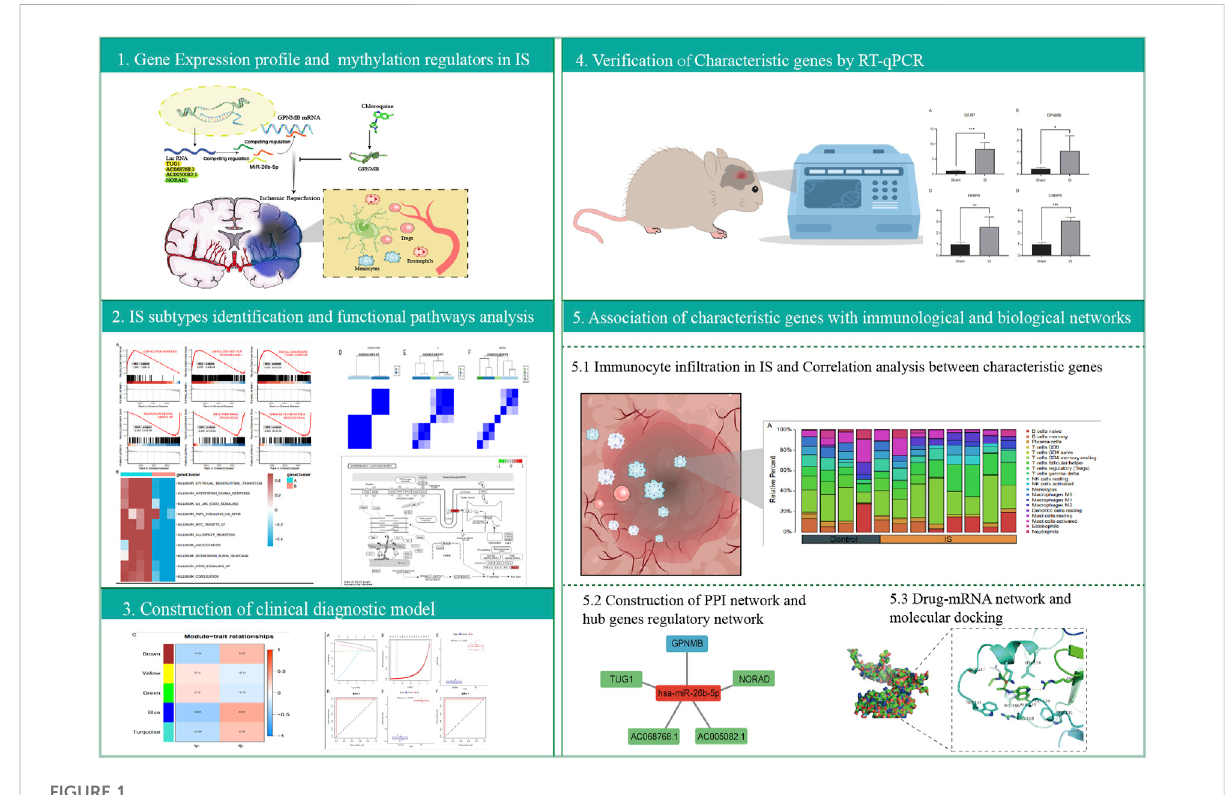
FIGURE 1 Protocol fl